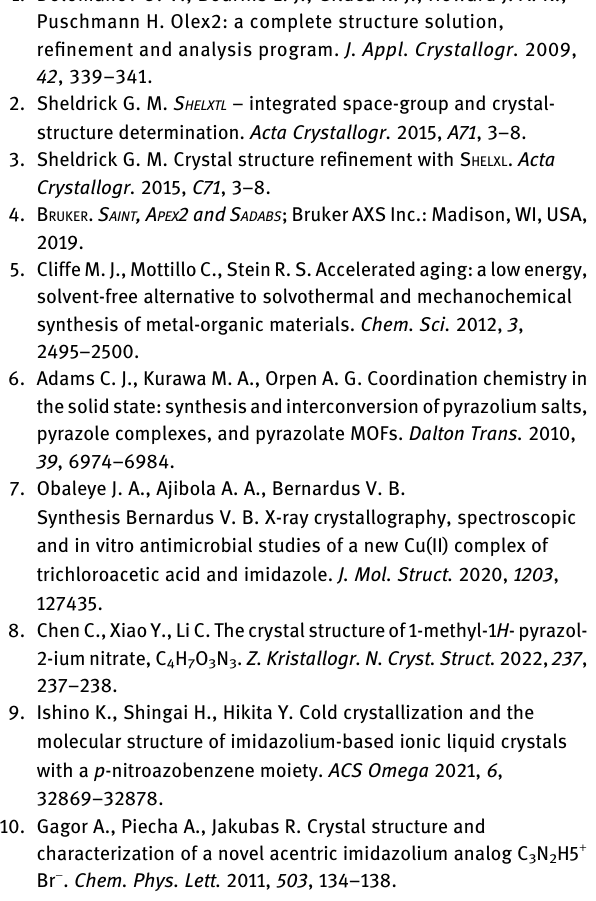
Table  : Fractional atomic coordinates and isotropic or equivalent isotropic displacement parameters (Å 